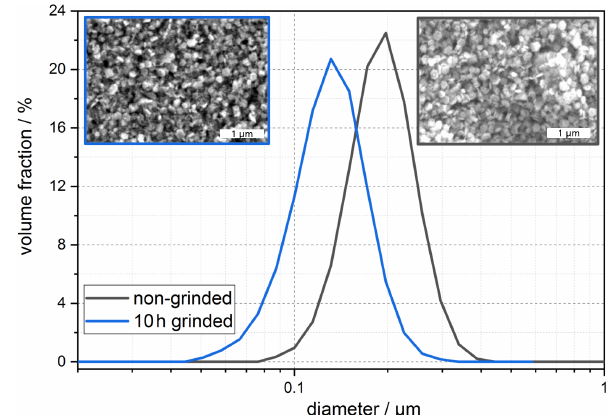
Figure 2. SEM images of (grey) the synthesised NiCo 2 O 4 cata- lyst and (blue) after grinding for 10h. The grinding is necessary to obtain a particle size distribution compatible with the inkjet printer used. The graph shows the shift to smaller particle sizes after the grinding. The peak maximum shifts from about 0.2 to